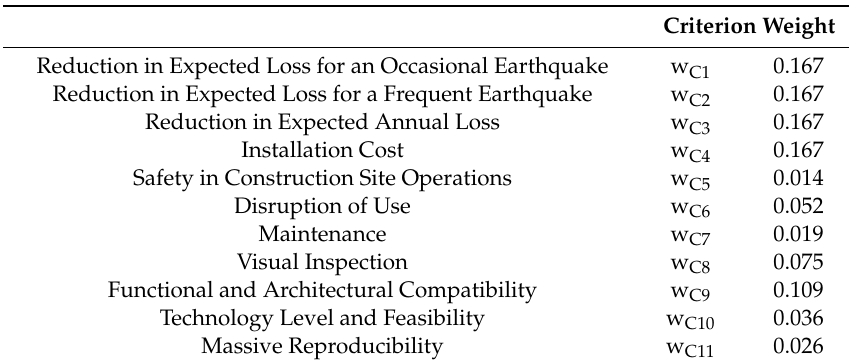
Table 9. Criteria Weight